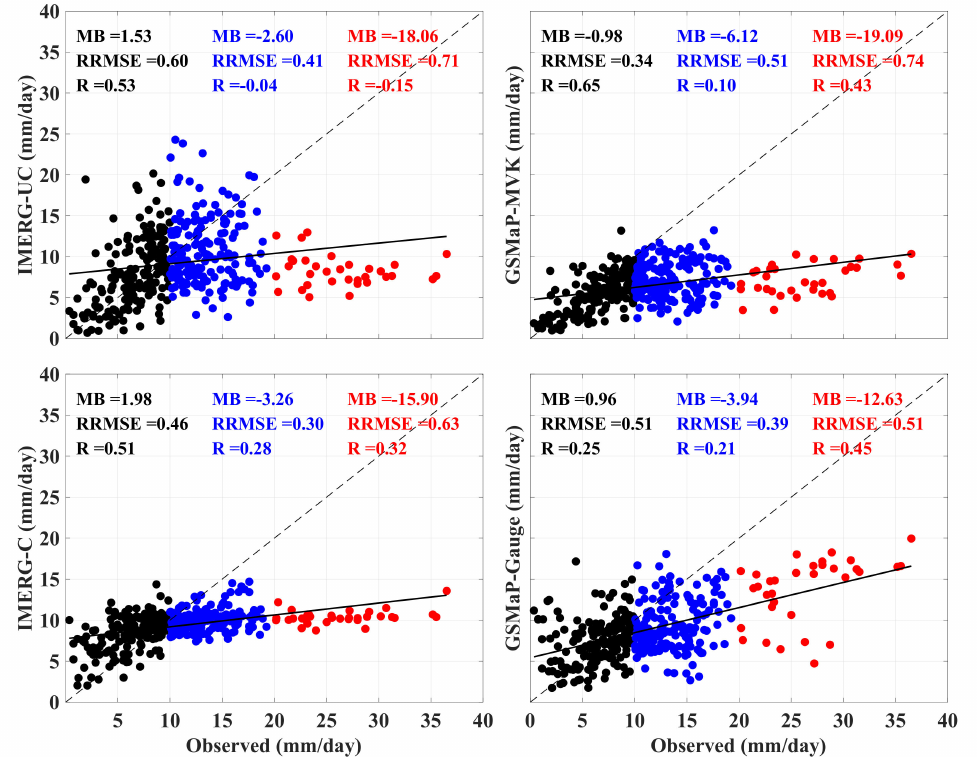
Figure 9. Scatter plot of di ff erences in precipitation rates between gauge observed and SBP products, derived from monthly mean precipitation averaged over the monsoon season (mm / day). All the units of statistical metrics are in mm / day. Black, blue, and red colors indicate the performance statistics for precipitation rates less than 10 mm / day, between 10 and 20 mm / day, and above 20 mm / day, respectively. The continuous black and dotted black line represents the linear regression and 1:1 line,